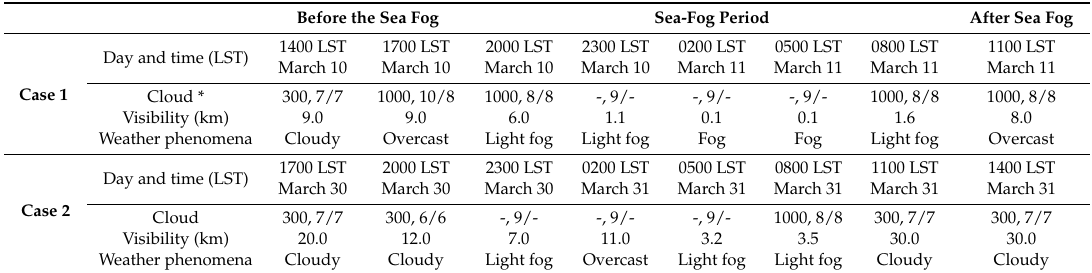
Figure 5. Relative humidity over sea and inland, and visibility inland. ( a ) Case 1. ( b ) Case 2. RH is relative humidity, VIS is visibility. The green line indicates the sea-fog period defined as RH > 95% over sea, the grey shading indicates inland fog defined as RH > 96.5%. Table 4. Weather observations inland (site C) during the sea-fog events.